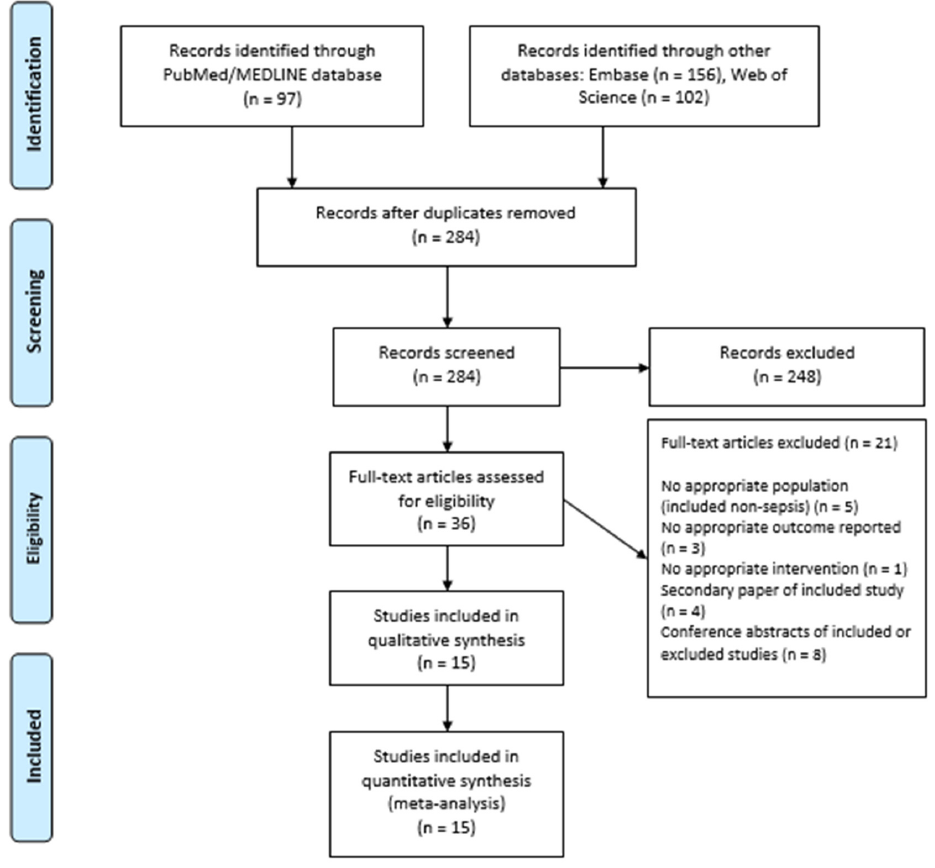
Figure 1. PRISMA flow diagram for the selection of studies.